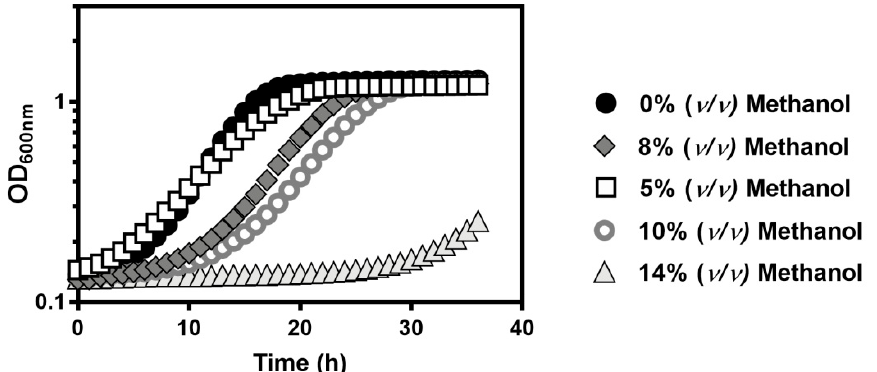
Figure 1. Comparison of the growth curves of S. cerevisiae BY4741 in YPD medium (pH 4.5) supplemented or not ( ) with 5% ( ), 8% ( ), 10% ( ), or 14% ( v / v ) ( ) of methanol. Growth was followed in a microplate reader by measuring the optical density at 595 nm of a 96-well plate incubated at 35 °C with orbital agitation, for 36 h .